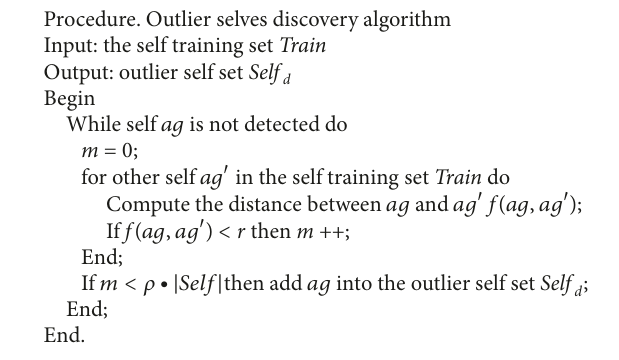
Procedure. Outlier selves discovery algorithm